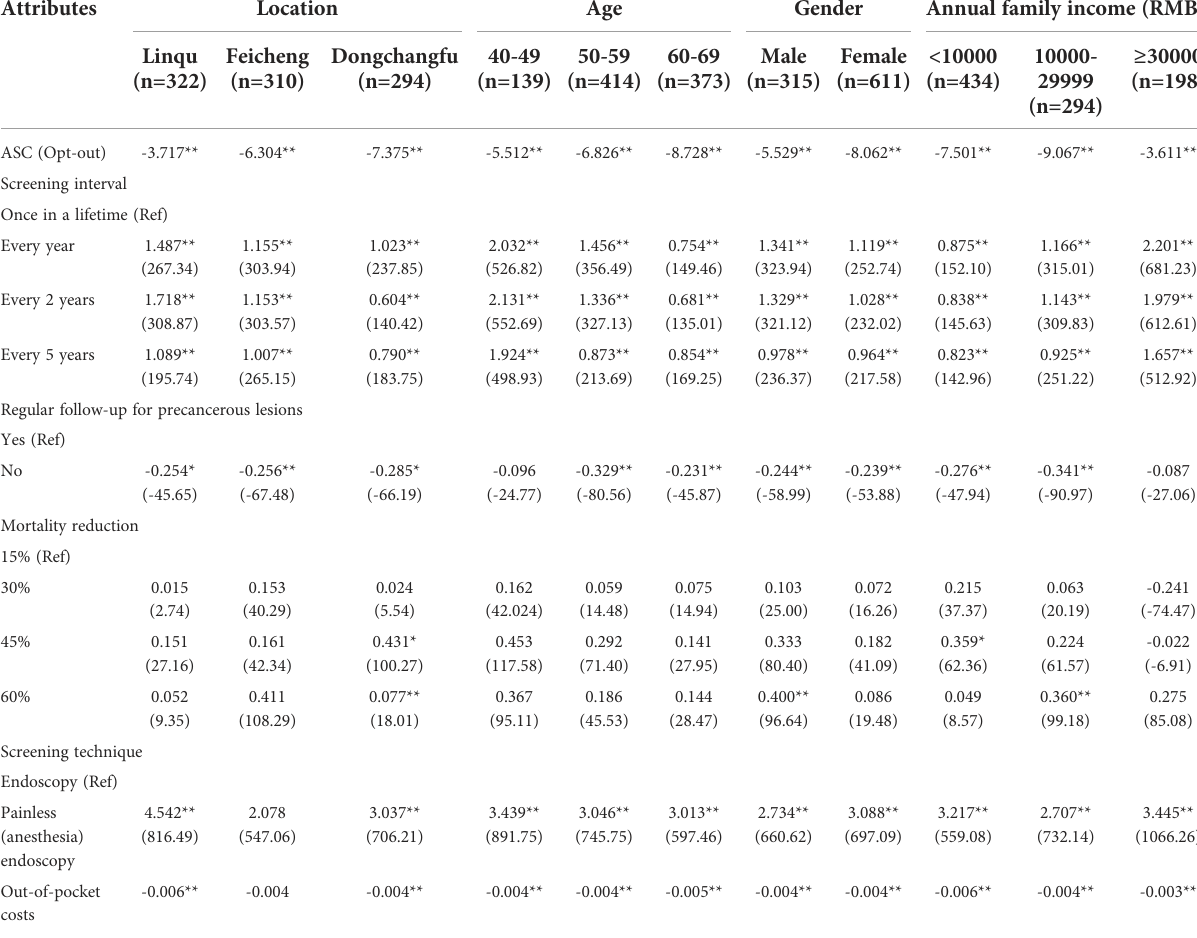
TABLE 4 The results of different subgroup analysis and WTP( b